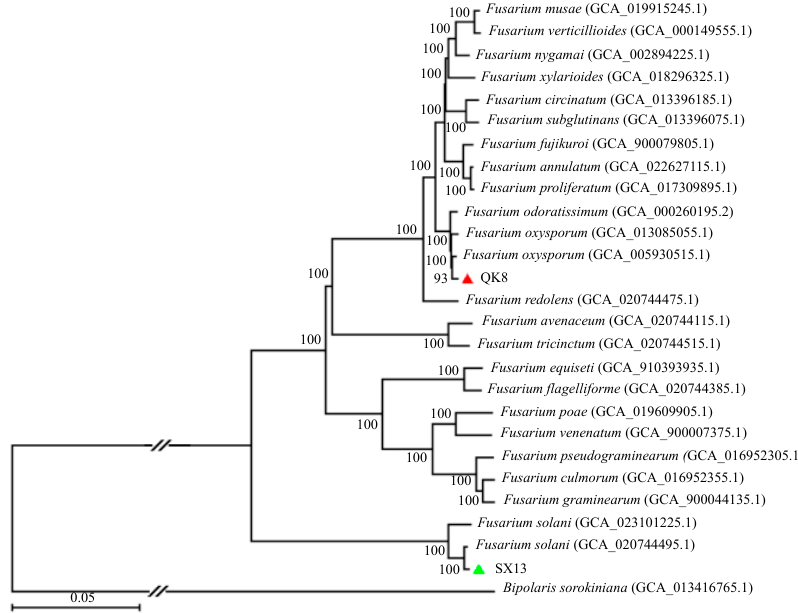
Figure 9. The genomic phylogenetic tree of strains QK8 and SX13 alongside 25 other species of fungi. There are 1739 single-copy homologous genes. The bootstrap value represents the percentage of related strains clustered together in the phylogenetic tree. The information in parentheses indicates the genome assembly fungal assembly, the triangle symbols indicate the location of strains F. oxysporum strain QK8 (red Δ ) and strain F. solan SX13 (green Δ ), and the root is Bipolaris sorokiniana .